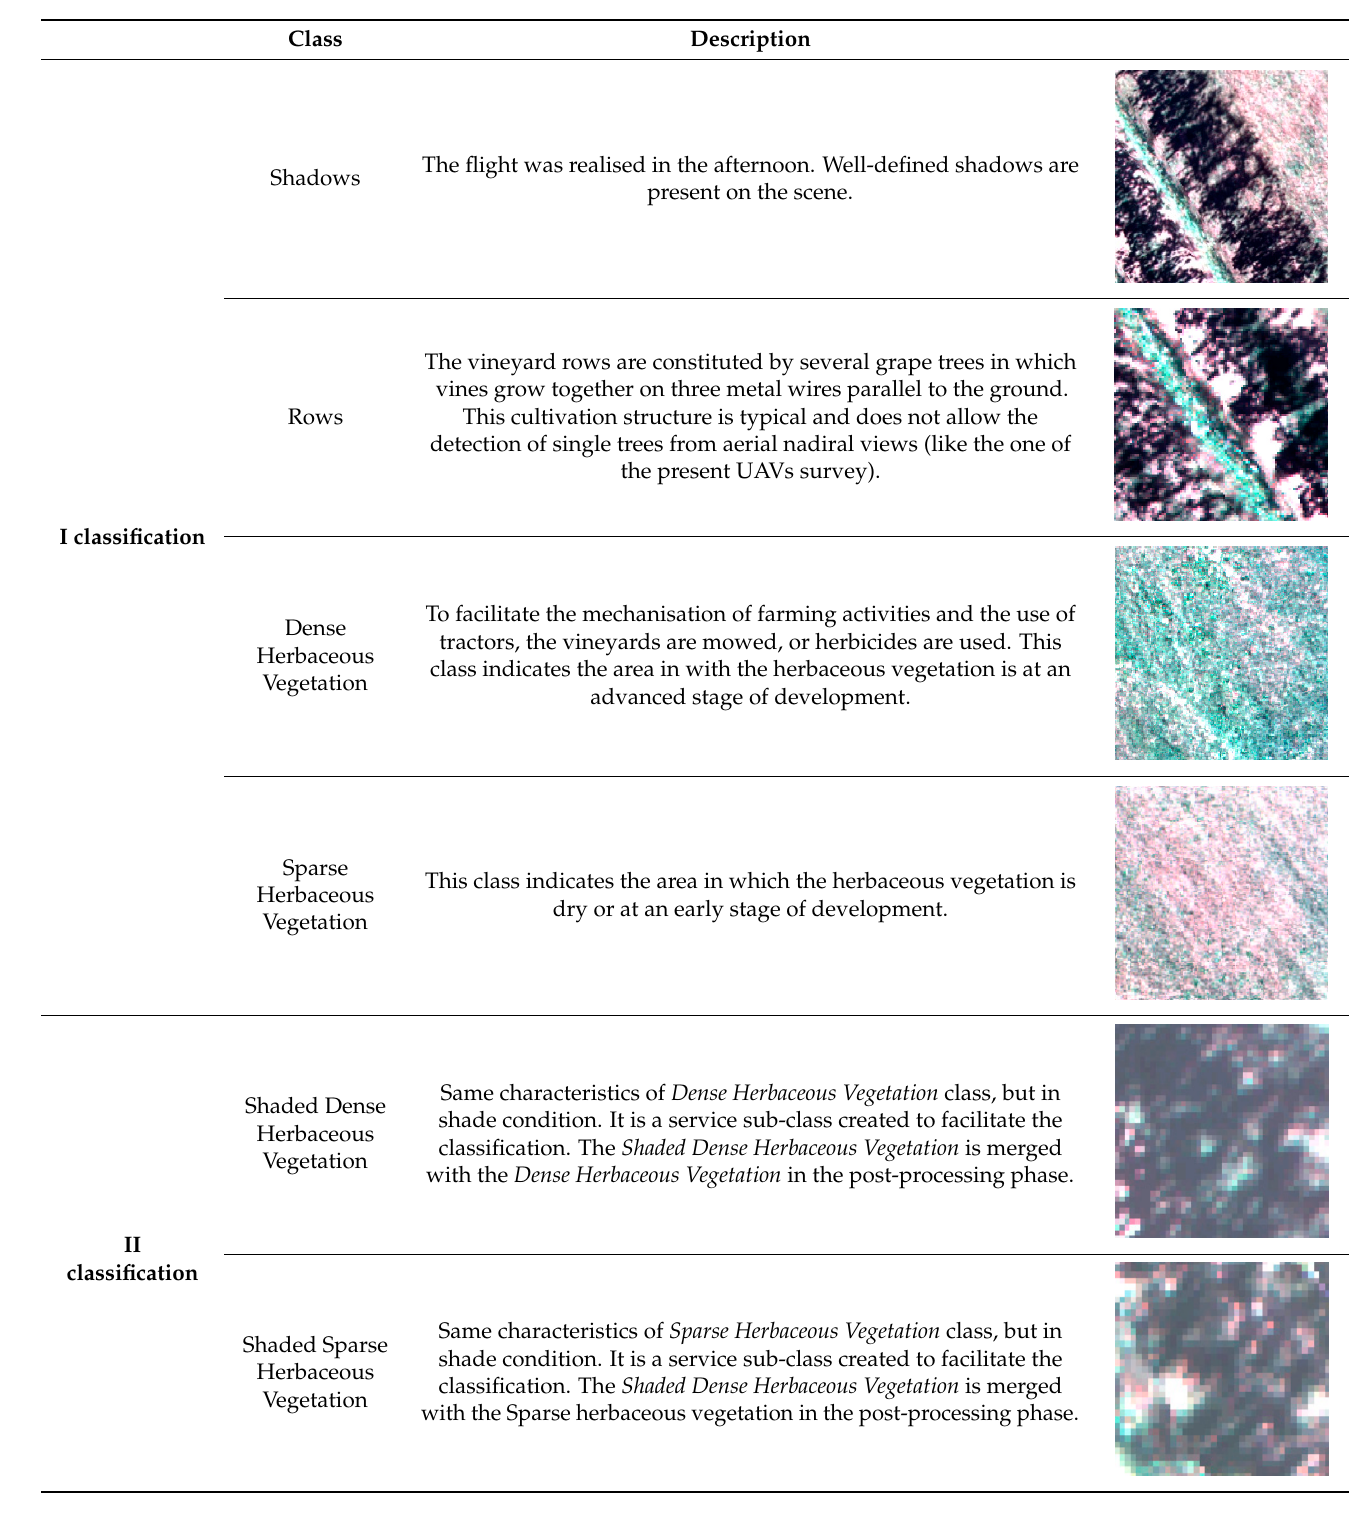
Table 3. List of derivative features selected and used in the classification dataset.